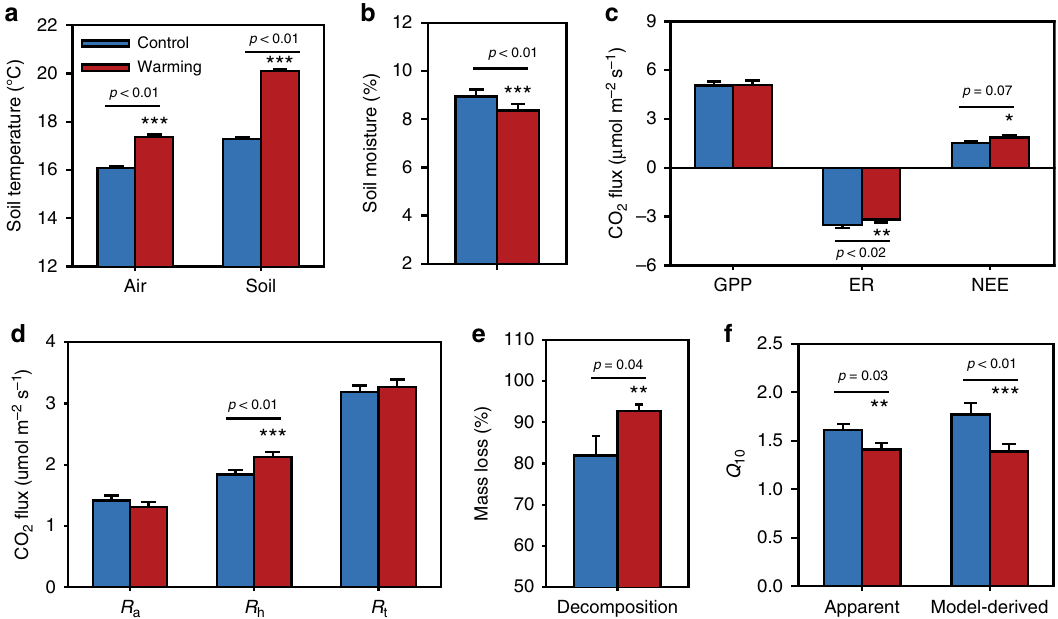
Fig. 1 Warming effects on soil variables and ecosystem C fl uxes. a Air and soil surface (7.5 cm) temperatures averaged from 2010 to 2016. b Soil moisture averaged from 2010 to 2016. c Ecosystem C fl uxes, which were estimated on the basis of the C amount from CO 2 emissions averaged from 2010 to 2016. GPP, gross primary productivity; ER, ecosystem respiration; NEE, net ecosystem C exchange. Positive values indicate C sink, and negative values represent C source. d in situ soil respirations averaged from 2010 to 2016. R a , autotrophic respiration; R h , heterotrophic respiration; R t , soil total respiration. e Decomposition rate of standard cellulose fi lter paper (mass loss) in the fi eld determined in 2016. f Apparent and model-derived temperature sensitivity ( Q 10 ) of heterotrophic respiration ( R h ) averaged from 2010 to 2016. Apparent Q 10 is estimated by fi tting the curve of R h versus soil temperature based on the Q 10 method. Model-derived Q 10 is derived by calibrating the MEND model. Error bars represent standard errors of the means ( n = 4 fi eld plots examined over seven repeated measures from 2010 to 2016). The differences between warming and control were tested by the two-sided repeated measures ANOVA, indicated by *** when p < 0.01, ** when p < 0.05, * when p < 0.10. Source data are provided as a Source Data fi